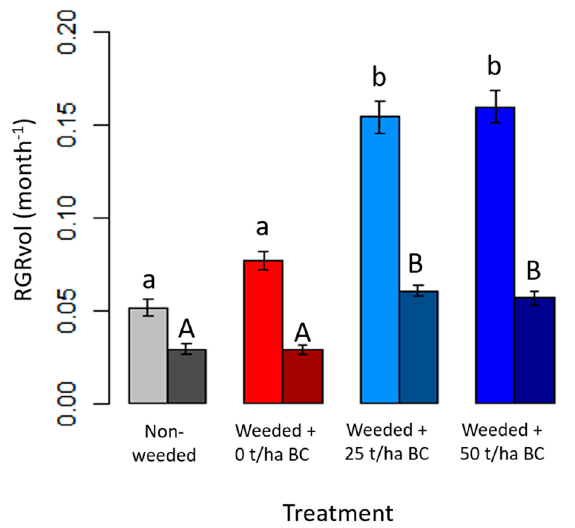
Figure 1. Relative growth rate (RGRvol) in all native seedlings and trees examined after 6 months (lighter colors) and 30 (darker colors) months. Weeding (strawberry guava removal) and biochar treatments at rates of 0, 25, and 50 t/ha are compared to the control (no weeding). Means are plotted as ± 1 SE; differences significant at p < 0.05 (Tukey HSD post hoc tests) are indicated by different letters (lowercase for 6-month RGRvol and uppercase for 30-month RGRvol).